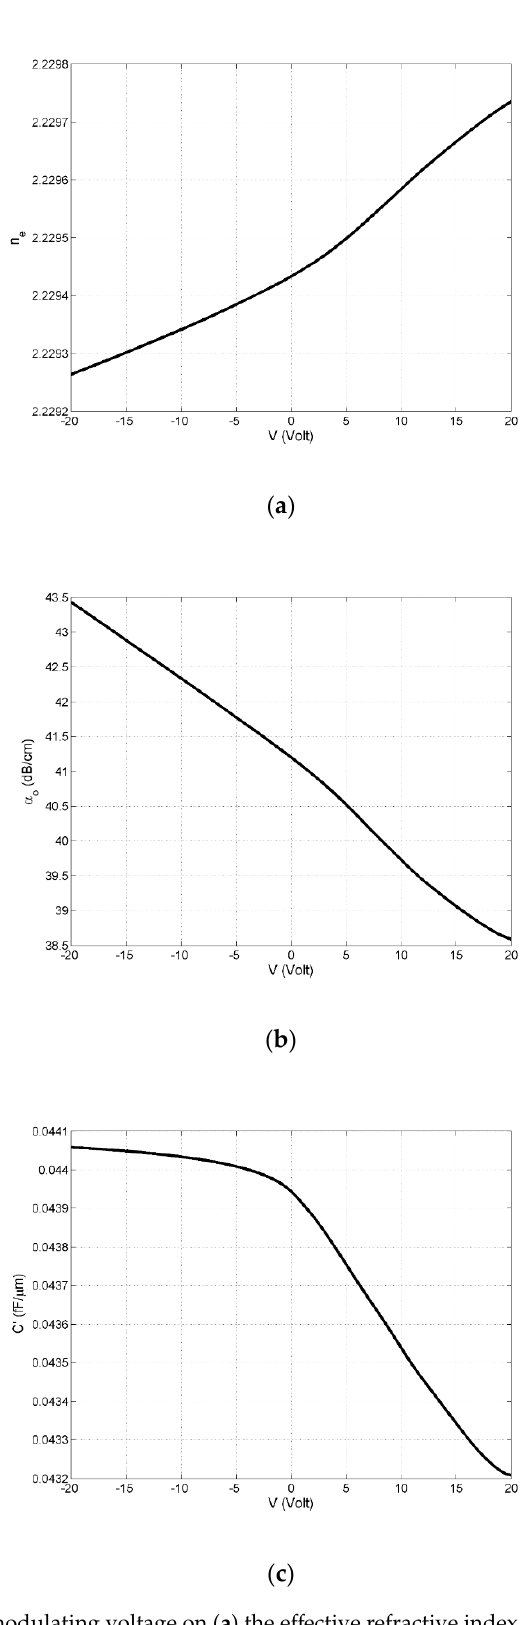
Figure 4. E ff ect of the modulating voltage on ( a ) the e ff ective refractive index, ( b ) the phase shifter loss, Figure 4. Effect of the modulating voltage on ( a ) the effective refractive index, ( b ) the phase shifter and ( c ) the capacitance per unit length, for ‘Modulator loss, and ( c ) the capacitance per unit length, for ‘Modulator B’.